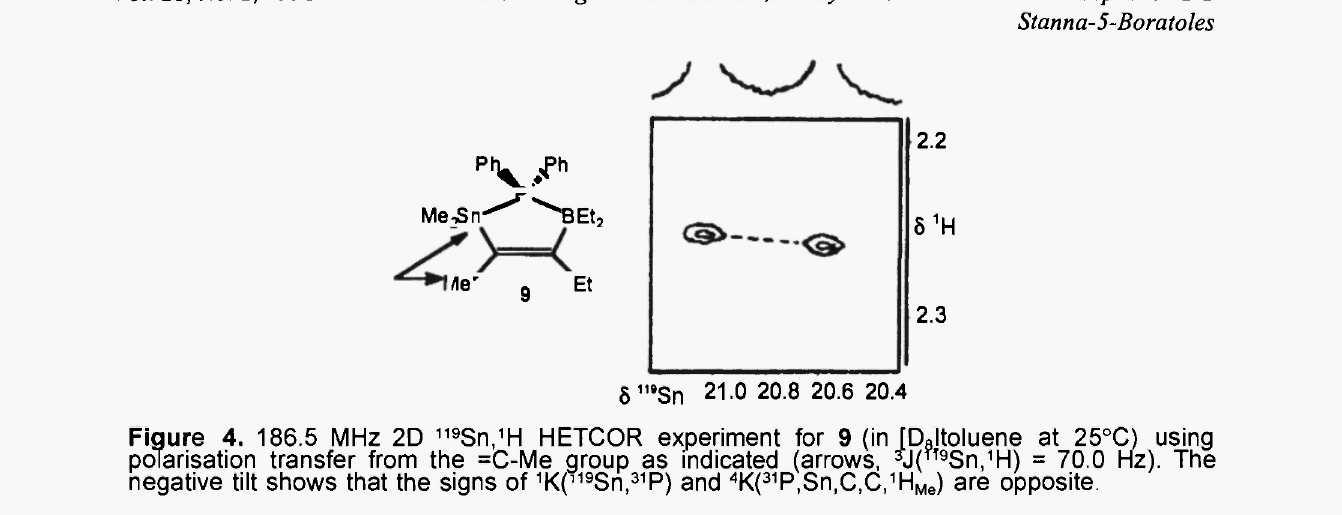
Figure 4. 186.5 MHz 2D 119 Sn, 1 H HETCOR experiment for 9 (in [D«ltoluene at 25°C) using polarisation transfer from the =C-Me group as indicated (arrows, 3 J(™ 9 Sn, 1 H) = 70.0 Hz). The negative tilt shows that the signs of 1 K( Yl9 Sn, 31 P) and 4 K( 31 P,Sn,C,C, 1 H Me ) are opposite. CONCLUSIONS 2,5-Dihydro-1,2,5-azoniastannaboratoles can be obtained from 1 by cleavage of Sn-N bonds. However, steric crowding may cause side reactions (see Scheme 3) or even rearrangement into new heterocycles, such as the 1,2,5-azastannabora-cyclopentane derivative 5. There are three routes to 2,5-dihydro-1,2,5-phosphastannaboratoles. Depending on the substituents at the phosphorus atom, the coordinative P-B bond can be weak (8) or strong (9). These heterocycles are attractive targets for NMR spectroscopic